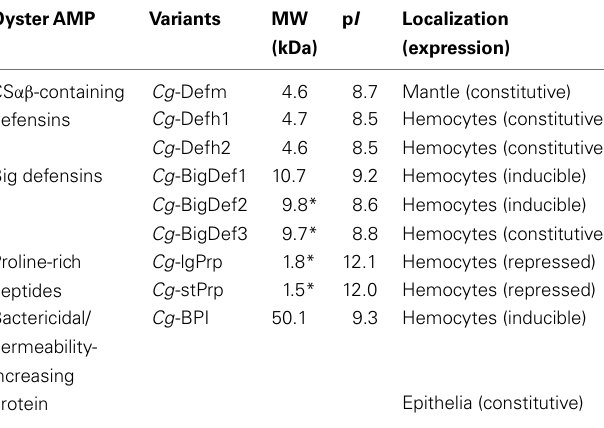
Table 1 | Oyster antimicrobial peptides and proteins